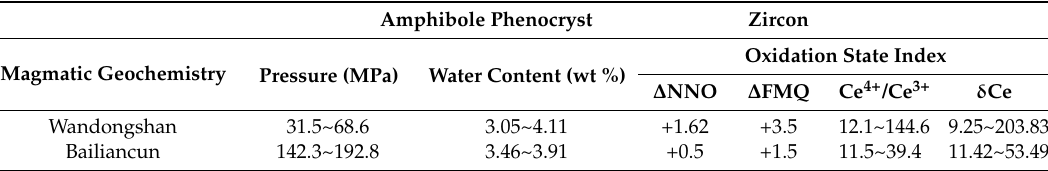
Table 2. The water content and oxidation state of the parental magmas from the Wandongshan and Bailiancun districts.